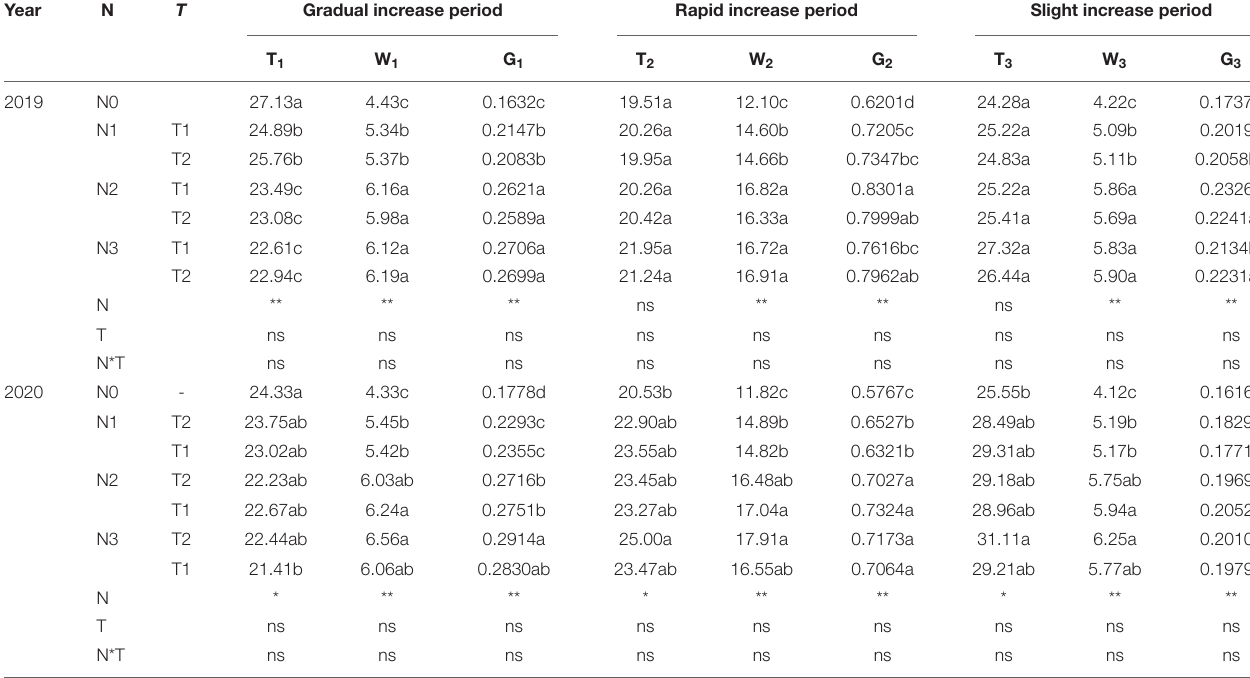
TABLE 4 | Effects of N rate and time on characteristics parameters of the three grain-filling phases of maize grains.